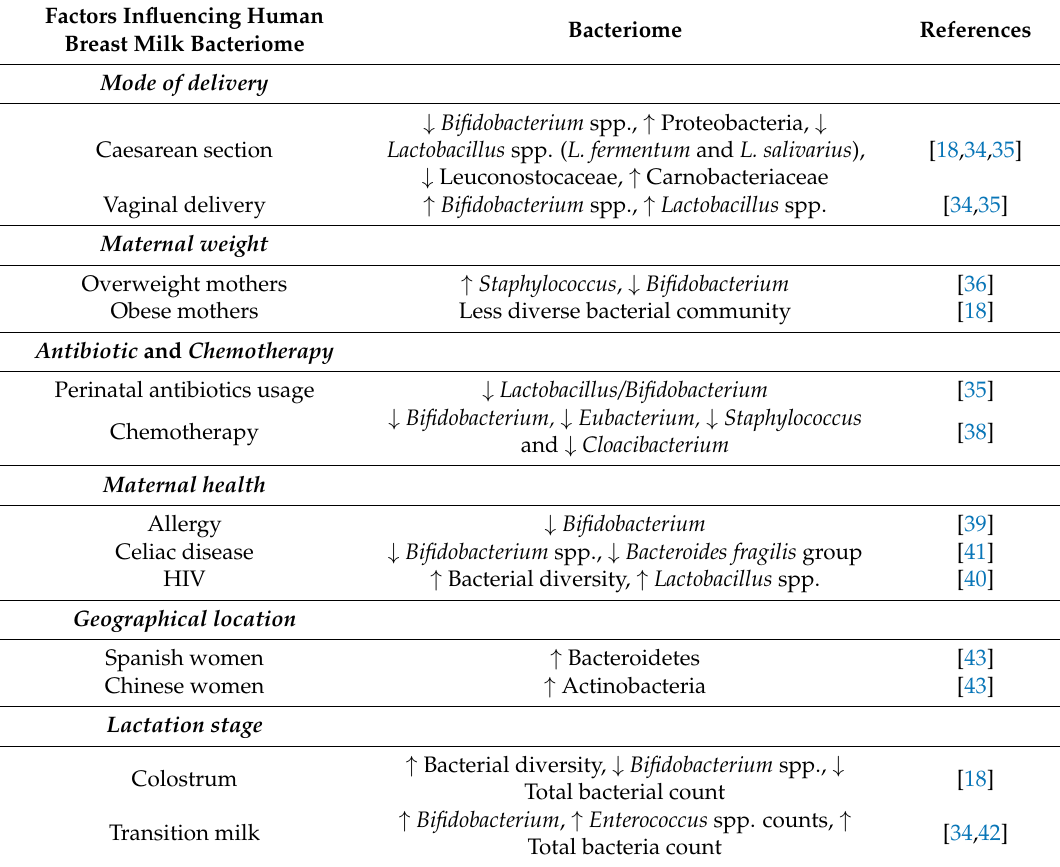
Table 1. Factors influencing human breast milk